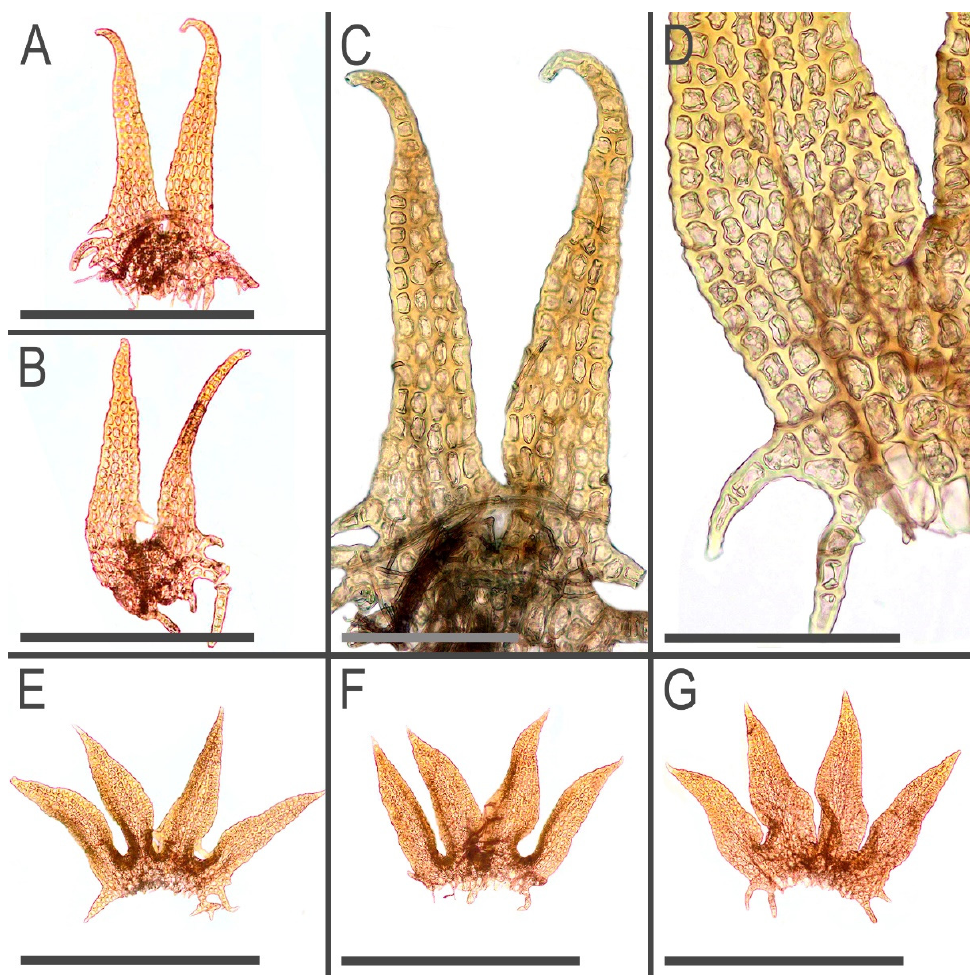
Figure 14. Tetralophozia pusilla (Steph.) Bakalin et Vilnet: A – C —underleaves; D —leaf lateral lobe base; E – G —leaves. Scales: A , B —300 µm. C , D —100 µm; E – G —500 µm. All from G00283395 (type).